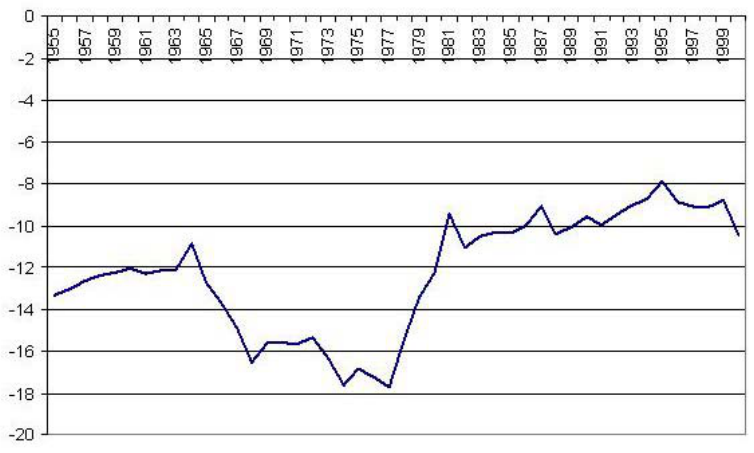
Figure 2. A Quandt Likelihood Ratio over